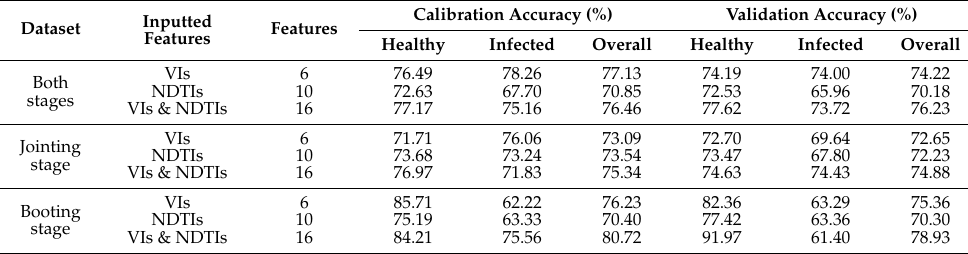
Table 3. Classification results of PLS-LDA model based on different features.